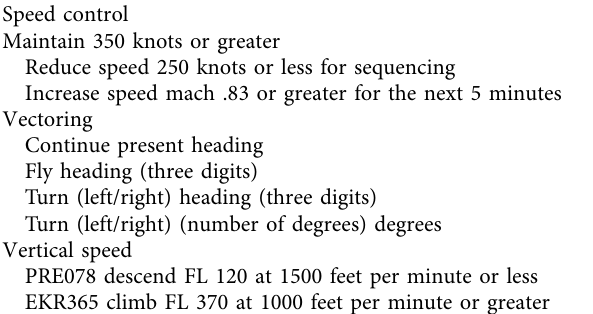
Table 9: Examples for basic ATCO’s command for speed control, vectoring, and vertical speed.